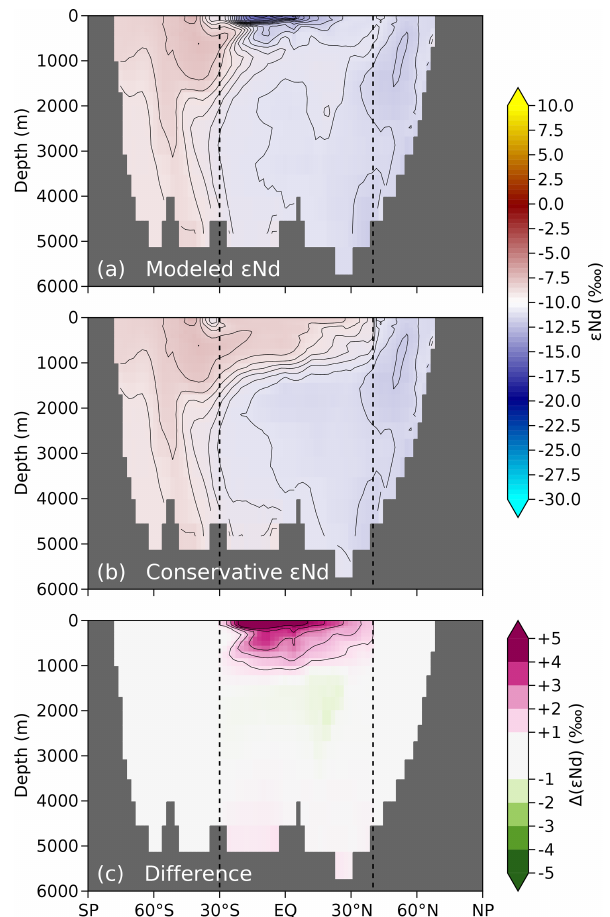
Figure 14. (a) Atlantic zonal average of modeled ε Nd . (b) Same for conservatively transported ε Nd from regions (cid:127) S and (cid:127) N . (c) Differ- ence between panels (a) and (b) . Contour lines are shown for each 1 increment. (Contour lines for (cid:49)(ε Nd ) > + 5 are not shown to avoid clutter). Regions are shown in Fig.